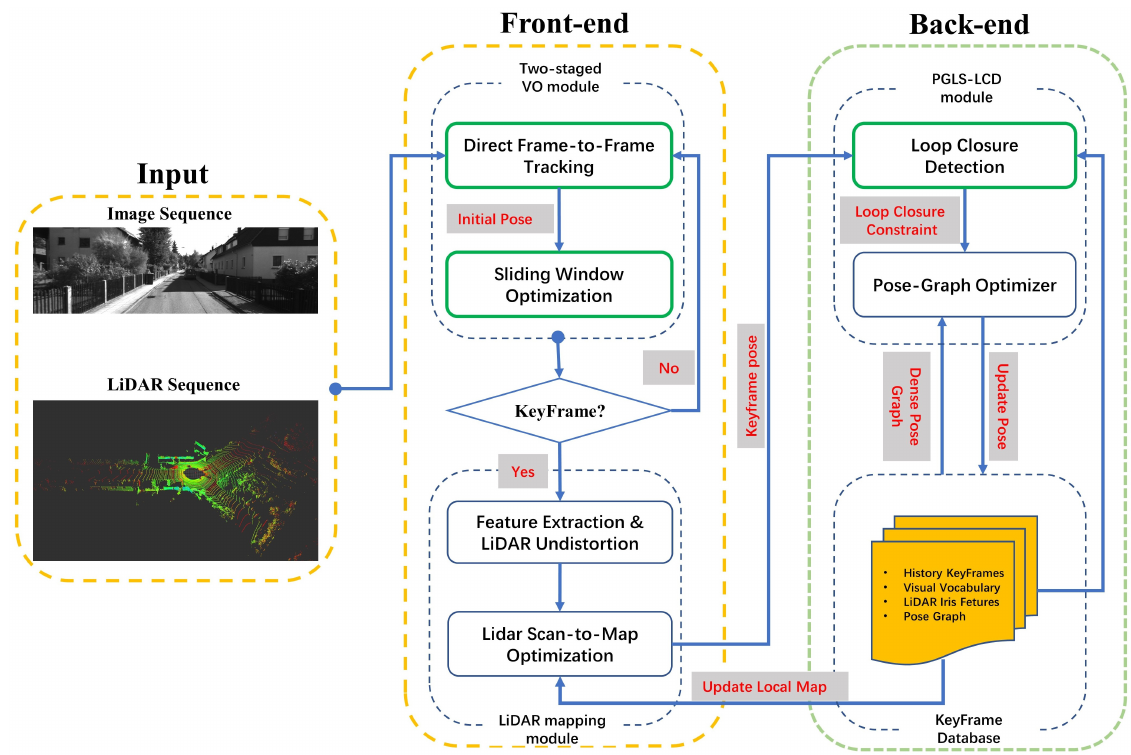
Figure 1. Algorithm overview of proposed Direct Visual LiDAR Odometry and Mapping. Our main contributions in this paper are highlighted in